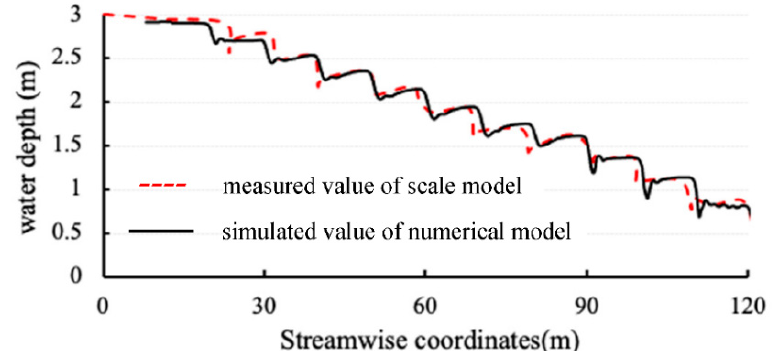
Figure 10. Water depth of Case S 1 obtained by two methods. The model experimental data and nu- merical simulation data both show an apparently fluctuating and discontinuous water surface line. They are in a good agreement due to similar resistance.